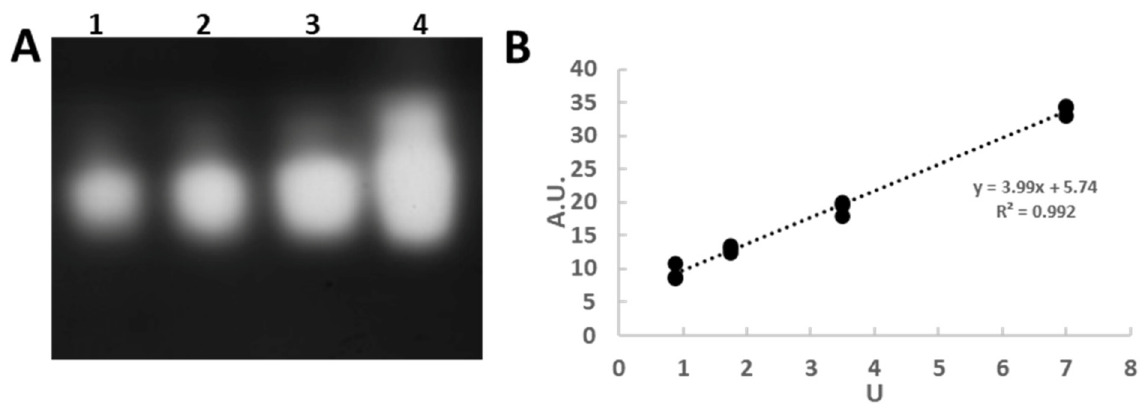
Figure 2. In-gel CAT assay. ( A ) Representative picture of a 7.5% native polyacrylamide gel revealing CAT achromatic bands due to competition for hydrogen peroxide between the enzyme and Prussian blue. Samples in lanes 1–4 represent 0.75, 1.75, 3.5, 7 standard catalase units (U). ( B ) Dynamic detection range (linear regression). Shown are the integrated density values (arbitrary unit) vs. standard bovine CAT activity obtained from three independent experiments.